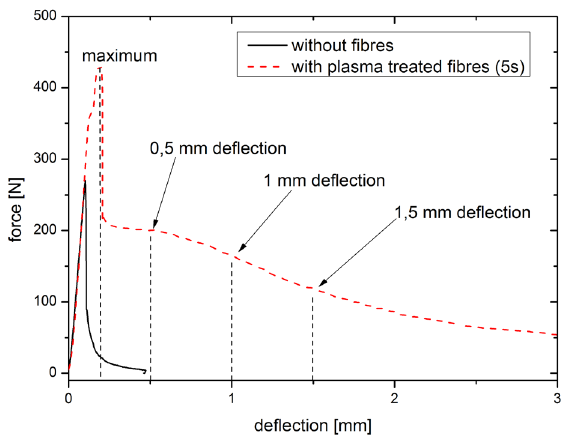
Figure 8: Description of the three-point test results for concrete samples with plasma treated fibres. The black line was added to show the qualitative difference between the samples with and without